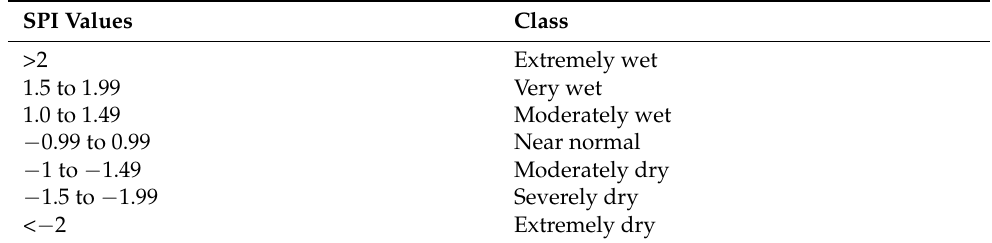
Table 2. Classification of drought based on SPI